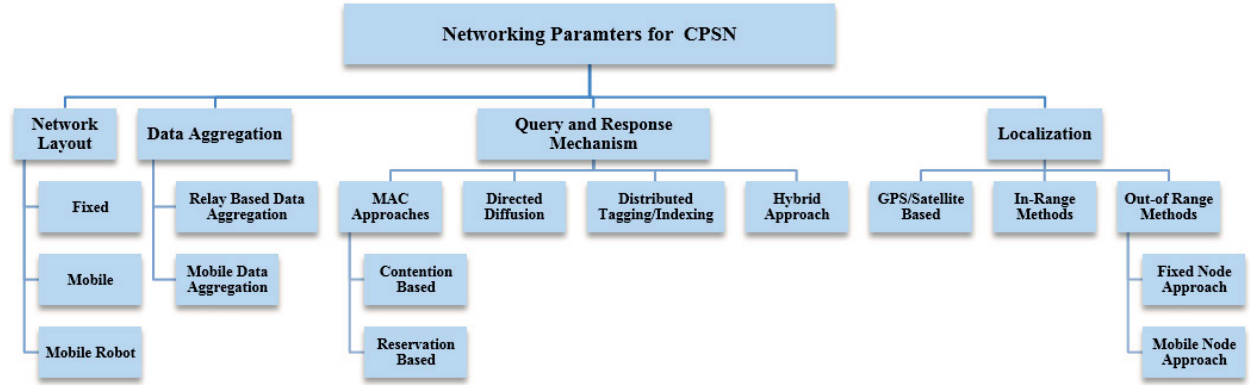
Figure 4. Network communication parameters for cyber physical sensor network